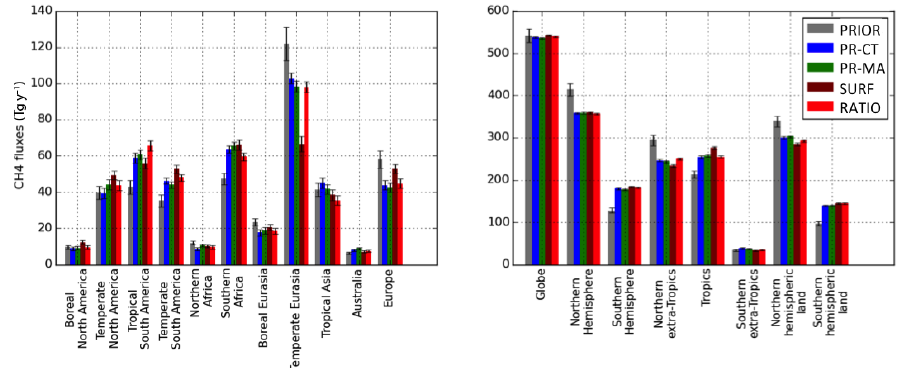
Figure 3. Annual fluxes of CH 4 integrated over different regions. The black line on each bar represents the ± 1 σ uncertainty.